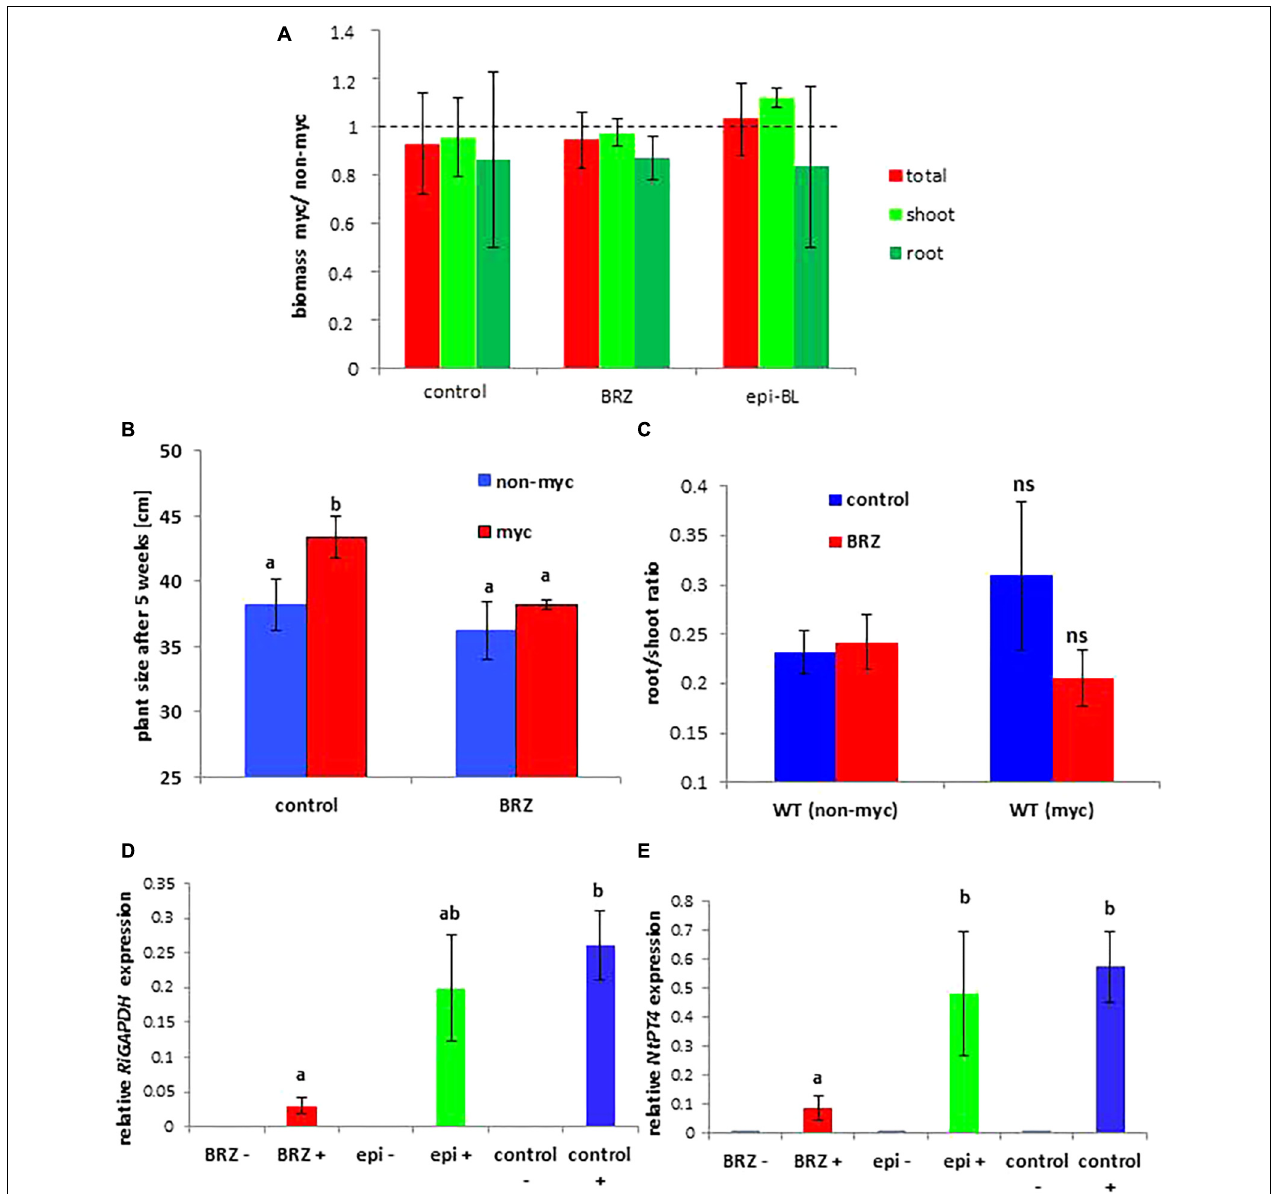
FIGURE 7 | Mycorrhization parameters as influenced by brassinazole (BRZ) and epi-brassinolide (epi-BL) treatment in tobacco WT plants. (A) Shown are mean values and standard deviations of mycorrhiza-induced increase in (A) plant biomass of five replicates of wild type tobacco plants treated or not with brassinazole (BRZ) or with epi-brassinolide (epi-BL). Although biomass parameters do not reveal significant changes, a biomass increase by mycorrhization is only observed in epi-BL treated plants. Tobacco WT plants were harvested after 9 weeks of colonization. (B) Mycorrhiza-induced increase in plant size is only observed in control plants, whereas the gain in biomass by mycorrhization is abolished by BRZ treatment. (C) root/shoot ratios of three replicates WT tobacco plants treated with or without BRZ. Tobacco WT plants in (B,C) were harvested 5 weeks after inoculation with R. irregularis . Results were highly reproducible in different experiments. (D, E) Quantification of fungal RiGAPDH (left) and tobacco NtPT4 (left) transcripts using tubulin as reference genes. Mean values and SEM are shown for three biological and two technical replicates. RNA accumulation values of RiGAPDH in non-mycorrhizal plants were below the detection level and are therefore not shown. One-way ANOVA with α = 0.05 reveals significant differences indicated by different letters.